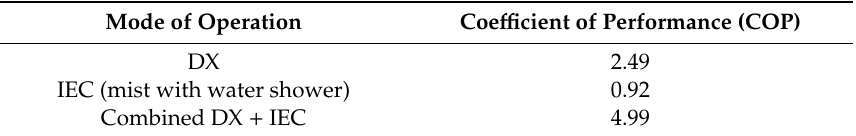
Table 3. COP calculated from experimental data for ambient temperatures less than 40 ◦